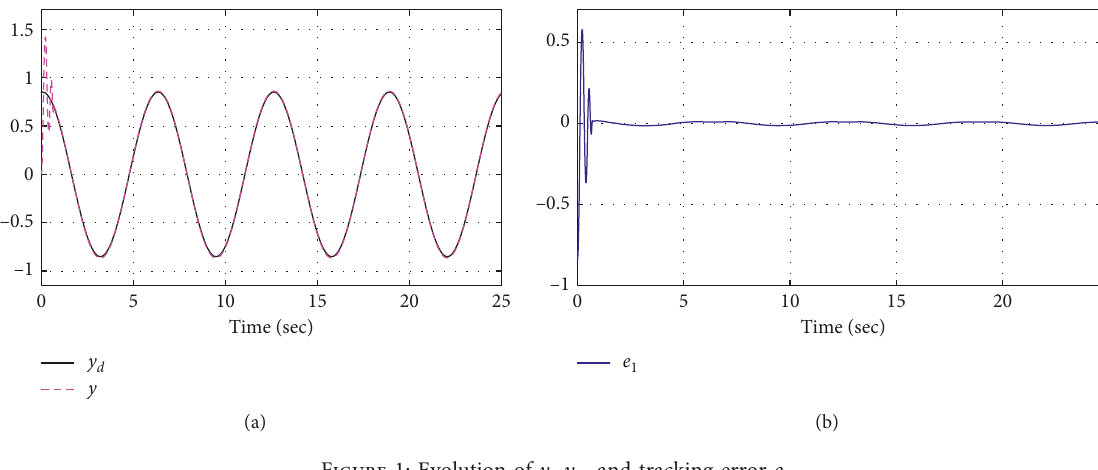
d , and tracking error